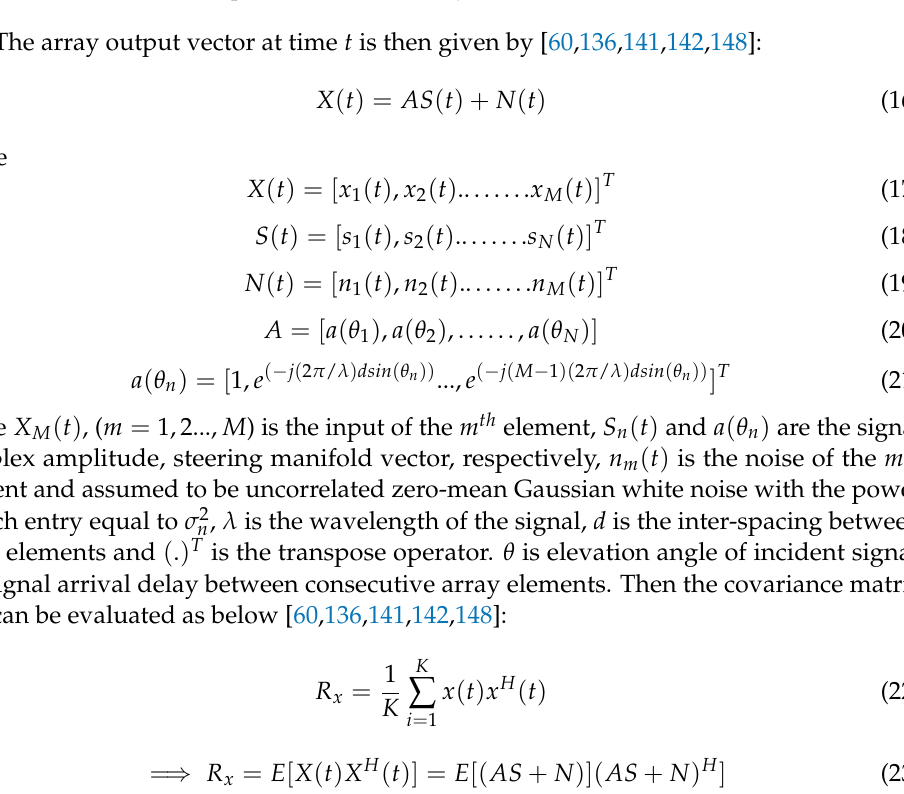
Figure 11. MUSIC ULA with phase shift between adjacent